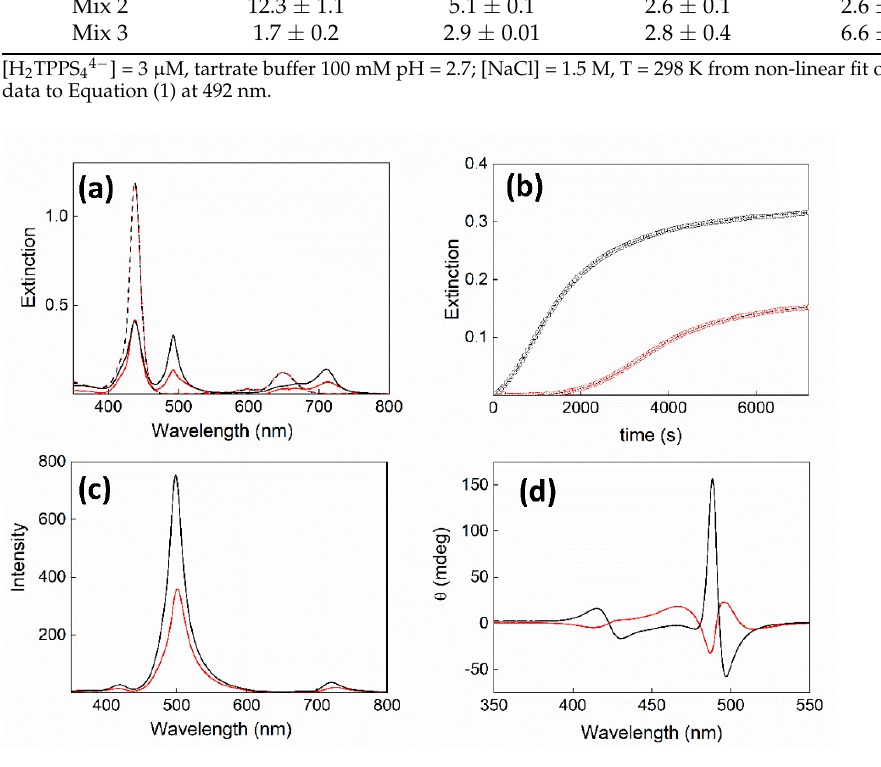
Figure 4. ( a ) Extinction spectra soon after initial mixing (dashed lines) and at the end of the aggregation (solid lines), ( b ) kinetic extinction time traces at λ = 492 nm (solid lines show the best fit of the experimental data according to Equation (1)), ( c ) RLS and ( d ) Circular dichroism (CD) spectra for the supramolecular assembling of H 2 TPPS 44- induced by salt and tartrate buffer (L: black lines; D: red lines) using mix 1 protocol. Experimental conditions: [H 2 TPPS 44- ] = 3 μ M; [NaCl] = 1.5 M; tartrate buffer 100 mM, pH 2.7, T = 298 K.